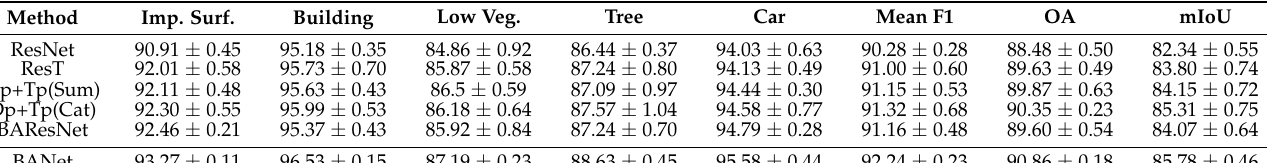
Table 4. The experimental results of the ablation study.